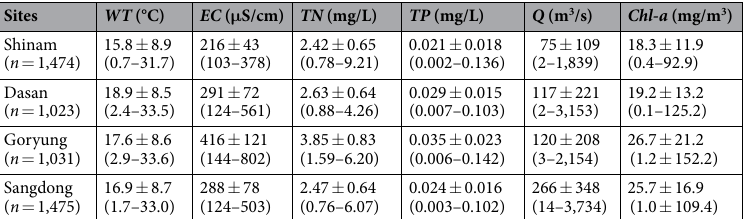
Table 1. Daily water quality and discharge data collected at monitoring stations in the Nakdong River for 5 years